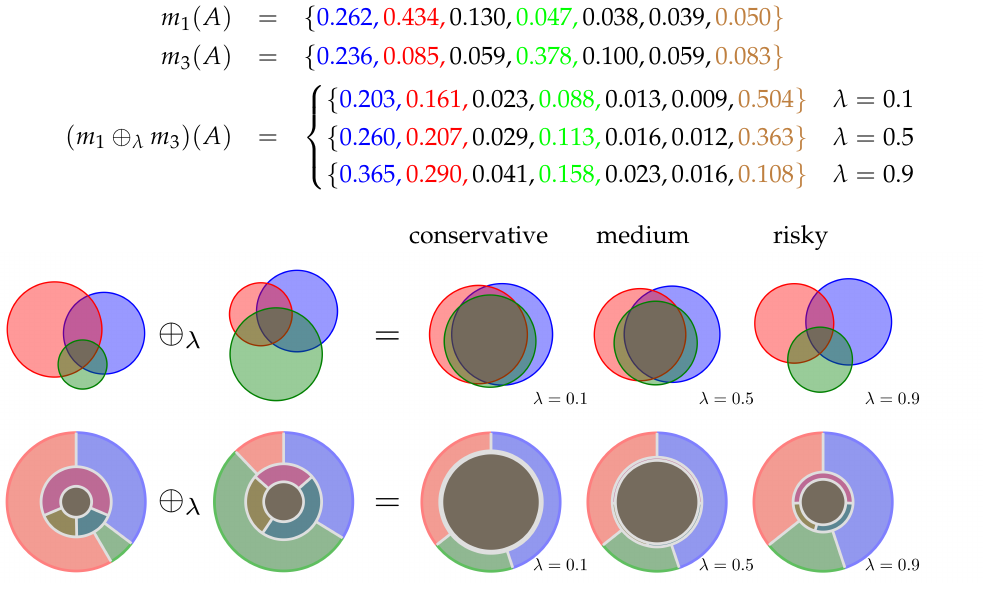
Figure A2. Adding two rather contradictory pieces of evidence with Formula (4). A smaller value of λ (more conservative) seems preferable staying on the safe side. Obviously none of the three possible outcomes receives the necessary support to represent a good choice. Contradicting masses should therefore be mostly allocated to total ignorance, m ( 7 ) = m ( Ω ) (compare Formulas (A1) and (A2)), displayed by the central grey